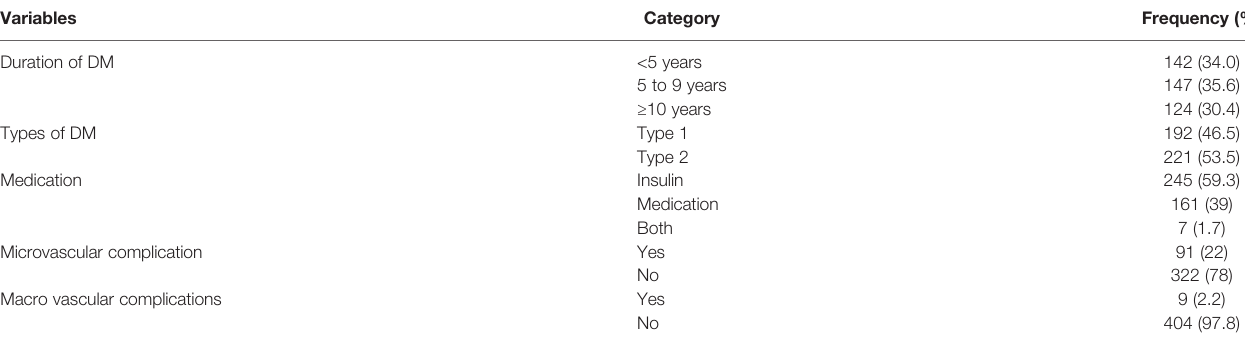
TABLE 2 | Clinical-related characteristics of diabetic patients in FHCSH, Bahir Dar, North West Ethiopia, 2020 (n = 413). Variables